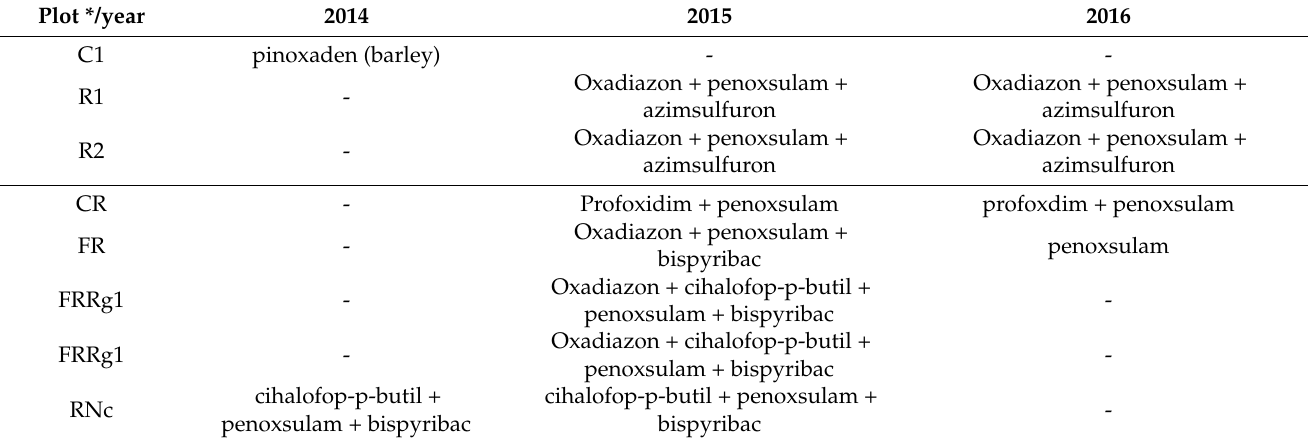
Table 2. Herbicides used in the different surveyed fields between 2014 and 2016 in Aragon,